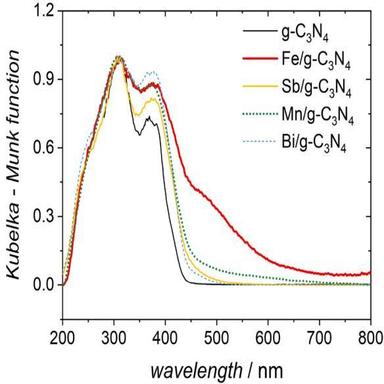
Transformed diffuse reflectance spectra of photocatalysts.